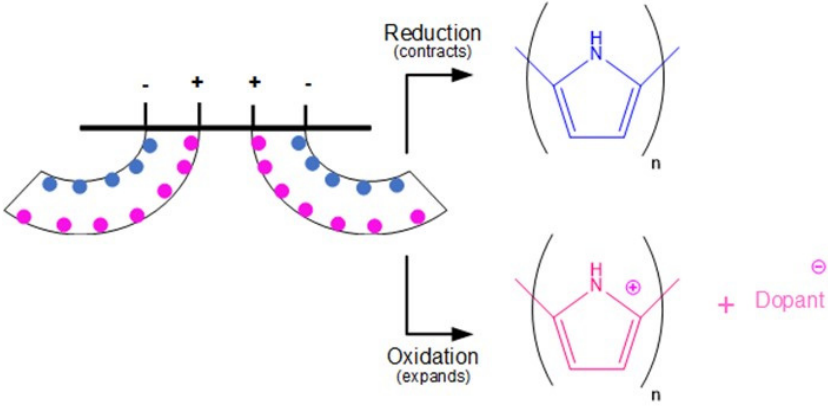
Figure 3. Schematic illustration of the anion-driven electro actuation mechanism of PPy.